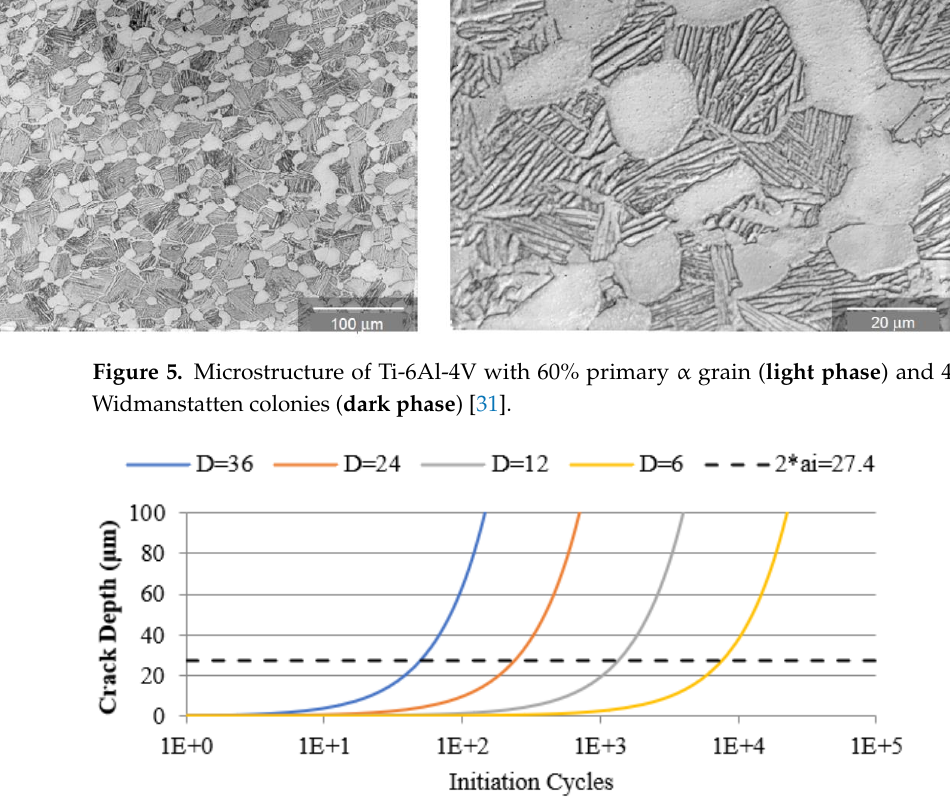
Figure 6. Crack length vs. initiation cycles for different values of the grain size.